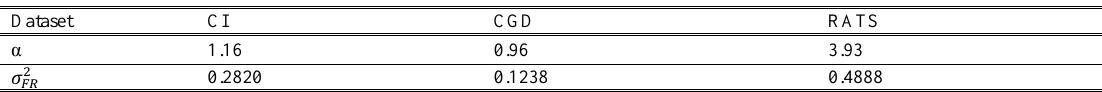
Table 1. Predicted hazard function plots for the datasets modelled on a Weibull baseline under a